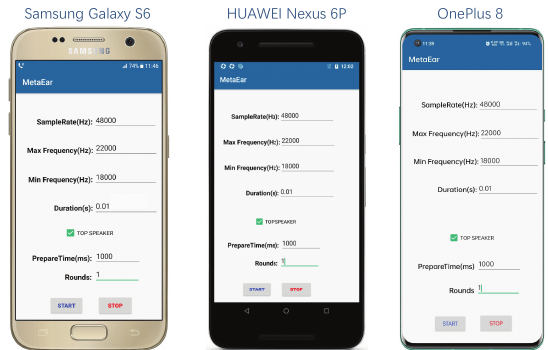
Figure 8. The Android APP and three